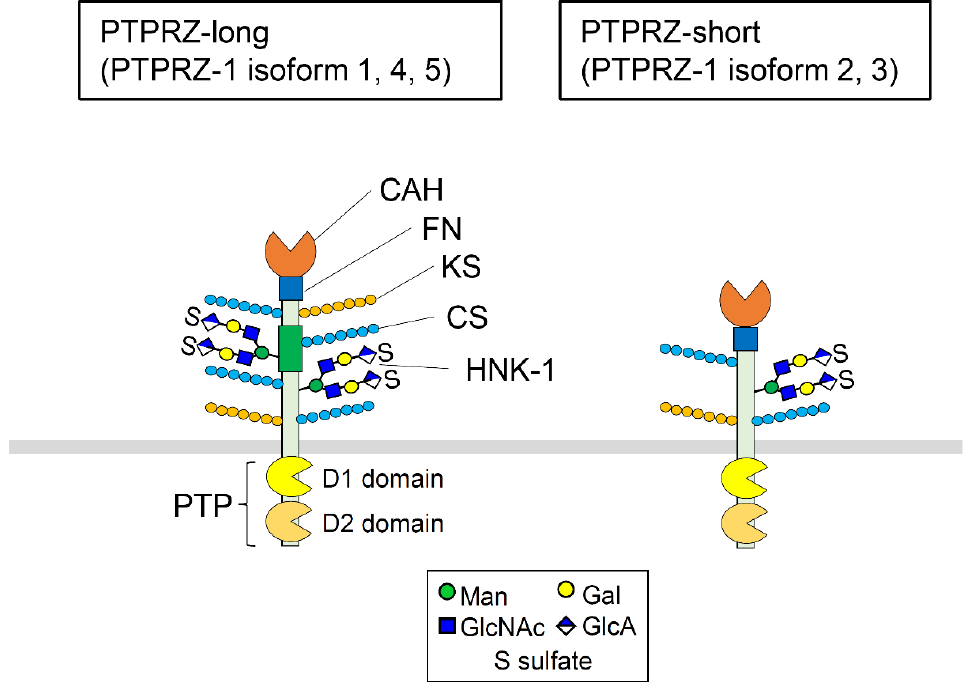
Figure 1. Molecular structure of PTPRZ. PTPRZ has an extracellular carbonic anhydrase-like domain (CAH), a fibronectin-like domain (FN), and two intracellular tyrosine phosphatase domains (PTP), namely D1 and D2. Furthermore, PTPRZ expressed in the central nervous system is highly modified by chondroitin sulfate (CS), keratan sulfate (KS), and HNK-1. PTPRZ does not appear to play an essential role in mammalian development, as mice lacking it develop normally [20]. Several studies have been carried out on the regulatory function of PTPRZ in the differentiation of OPCs into oligodendrocytes and its roles in myelination and learning and memory [6,21]; however, the underlying molecular mecha- nisms remain unclear. PTPRZ functions as a cell adhesion molecule, and binds with the